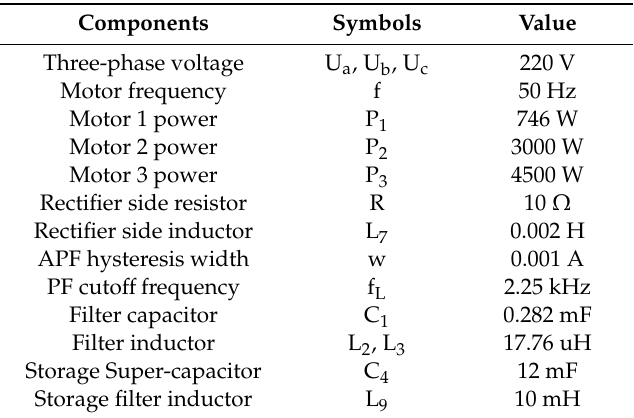
Figure 9. Active demand simulation circuit. Table 3. The main simulation parameters.